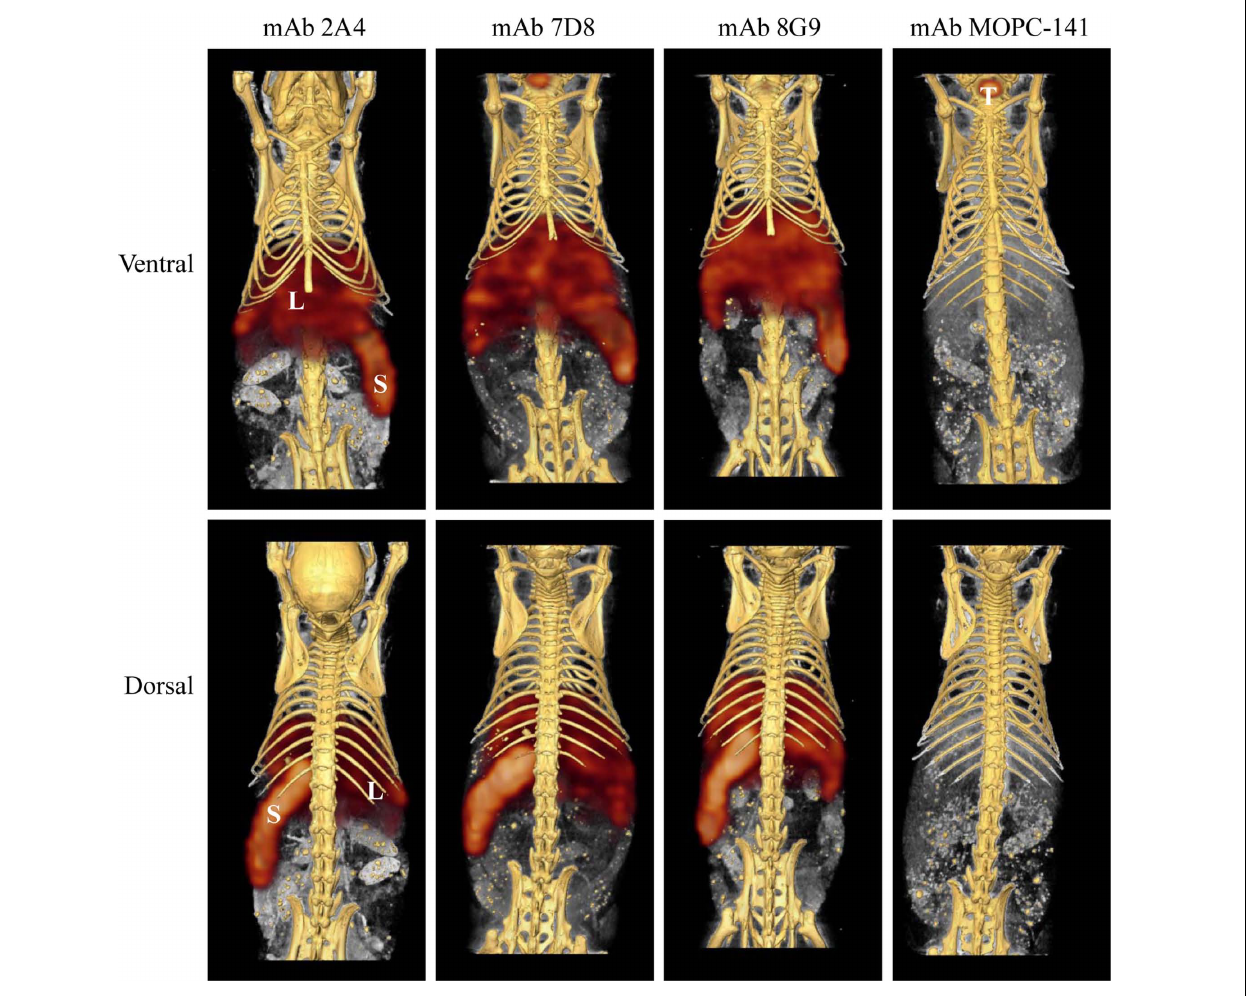
FIGURE 5 | Radioimmunoimaging ofAA amyloid. SPECT/CT images obtained 48h after AA amyloidotic mice were injected with ∼ 250 μ Ci of 125 I-labeled mAbs 2A4, 7D8, 8G9, or the isotype-matched control antibody,